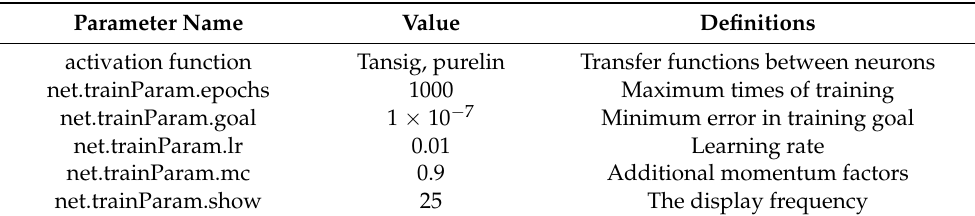
Table 2. Basic parameter settings of the backpropagation artificial neural network snow simulation model